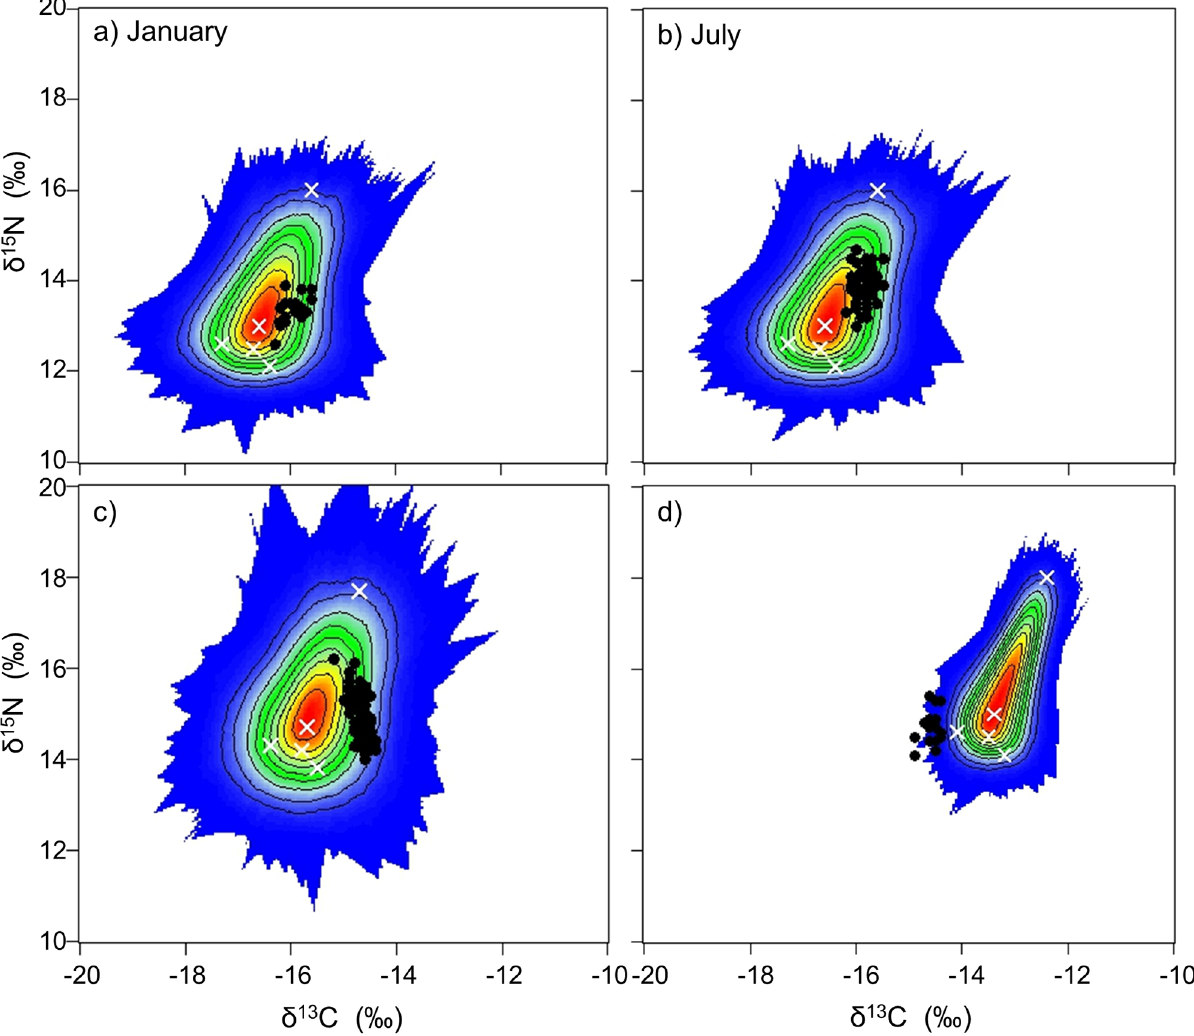
Fig 4. Simulated mixing region calculated with the five potential prey species (white crosses). Dark symbols represent the African penguin blood (a and b), feather (c) and egg membrane (d) data corrected with the tissue-specific trophic enrichment factors (see S2